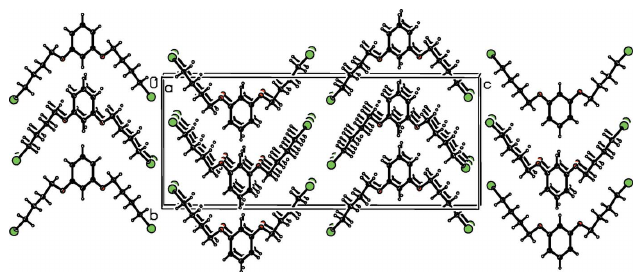
Figure 2 The crystal packing of the title compound, viewed along the a